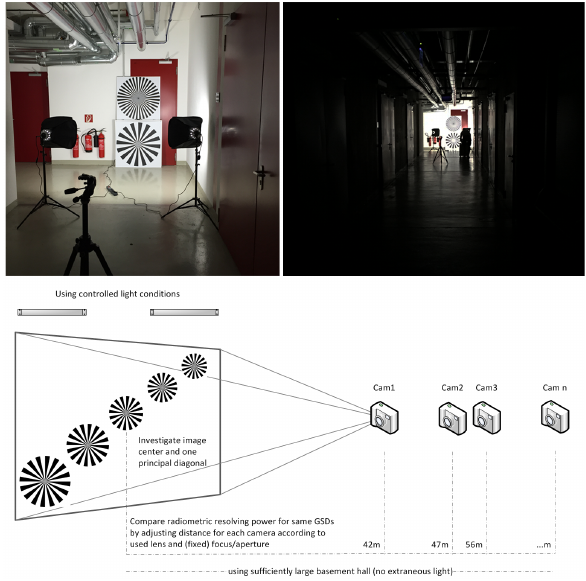
Figure 6. Controlled light conditions (top left), no extraneous light (top right). Illustration of the experiment setup (bottom) camera has a Foveon-sensor (Hubel et al., 2004) where each pixel element detects colour information instead interpolating neigh- bourhood pixel of a Bayer-pattern